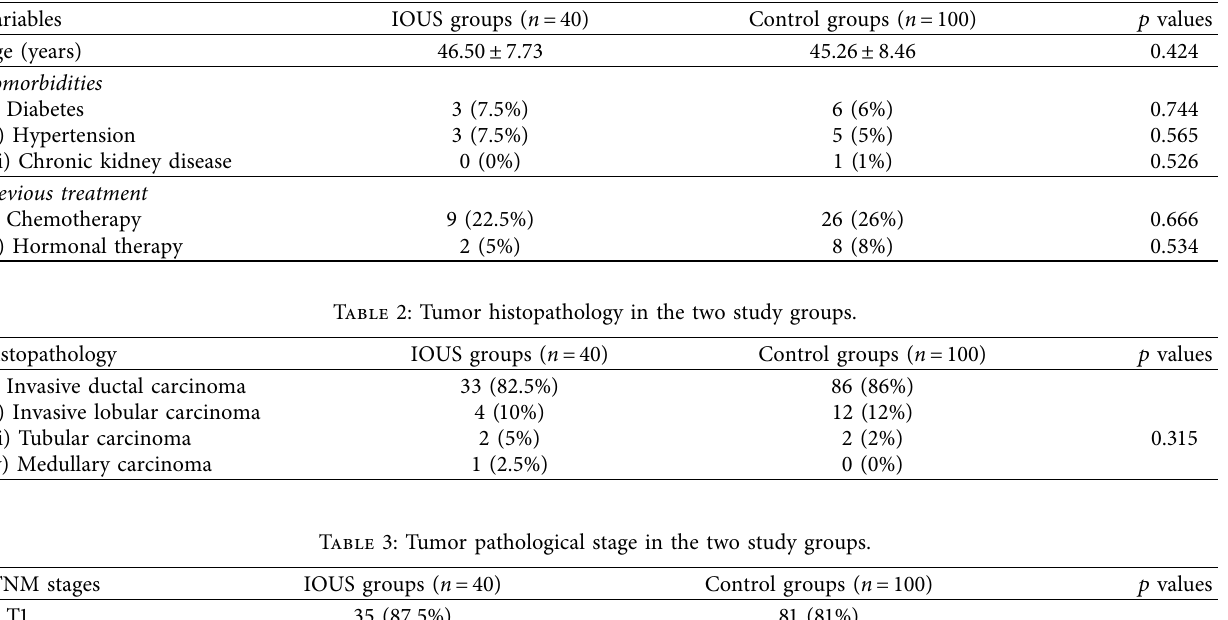
Table 1: Patient demographic and clinical criteria in the two study groups.